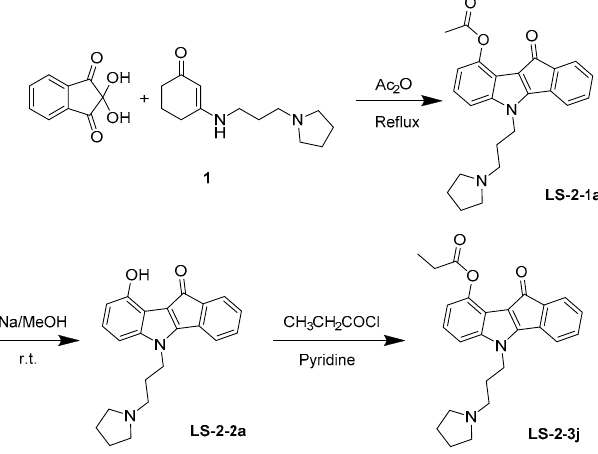
Figure 7. Synthesis and chemical structure of LS-2-3j.